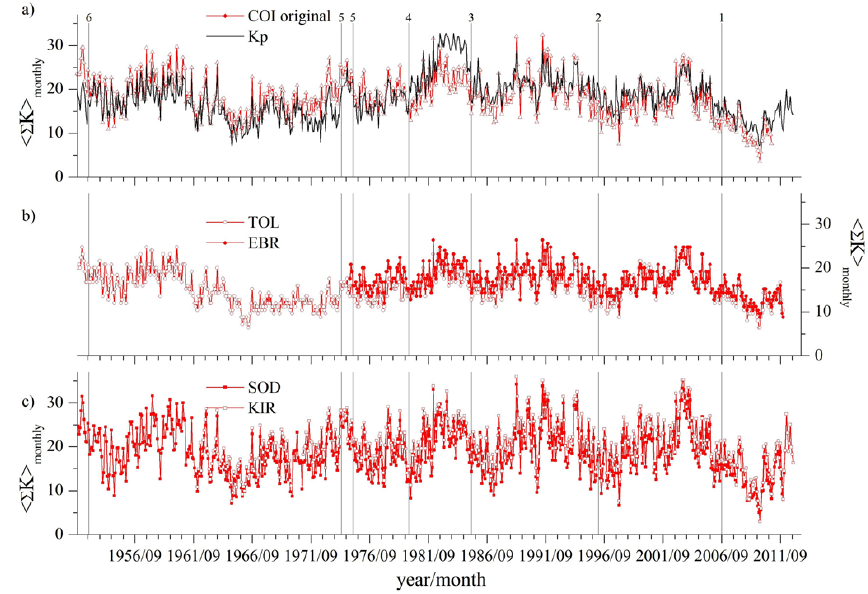
Fig. 1. Original COI Ki series (a) and references series: Kp (a) , TOL Ki and EBR Ki (b) , and SOD Ki and KIR Ki (c) . Vertical lines mark periods of possible homogeneity breaks for COI data (see Table